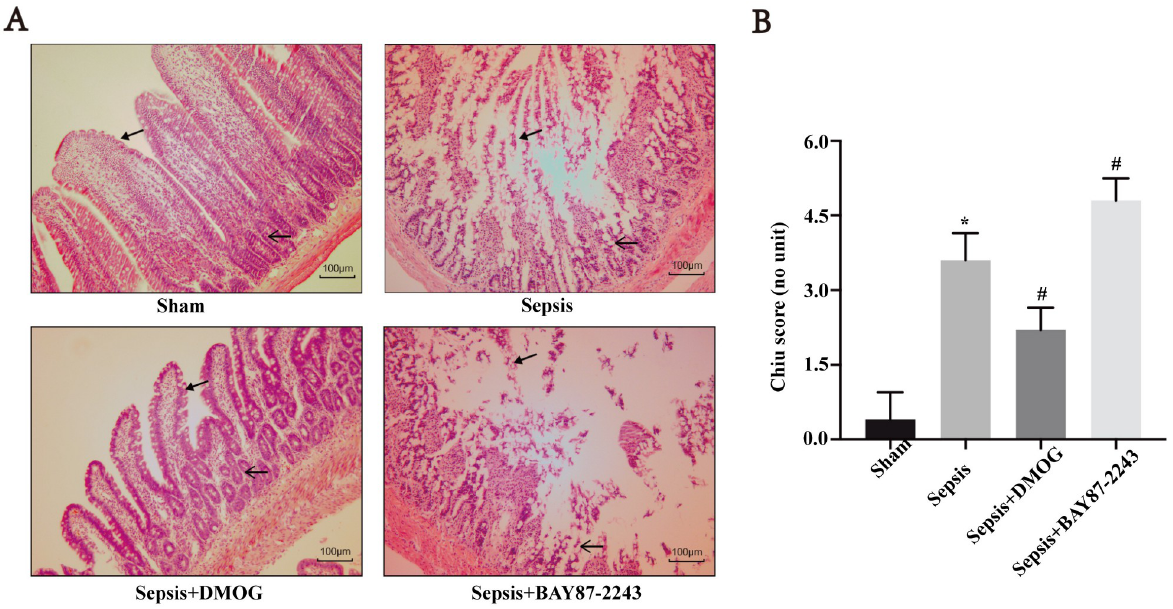
Fig 1. Effects of an HIF-1 α activation/inhibition on the intestinal mucosa in septic rats, as shown by HE staining ( × 200) and the Chiu score of ( n = 6 except sepsis + BAY 87–2243 with n = 5). Data are expressed as the mean (SD). A. Representative images showing the intestinal morphology (HE staining, magnification × 200). B. Intestinal mucosa injury was quantitatively assessed by calculating the Chiu score; � P < 0.05 compared with the sham group; # P < 0.05 compared with the sepsis group.